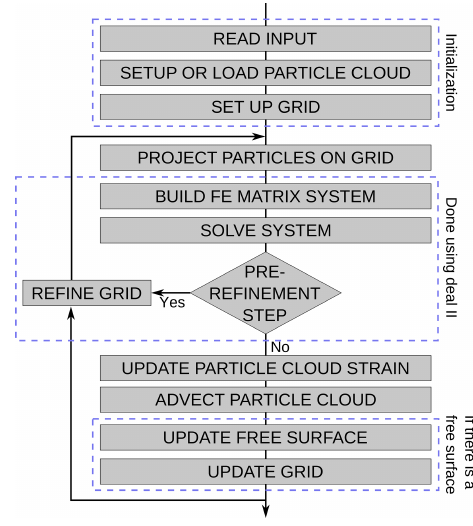
Figure 2. Schematic workflow of the FAIStokes code structure. The pre-refinement step occurs at the beginning of the simulation (or during a re-initialization of the grid) to ensure that the velocity used for the advection step is computed using the adaptively refined